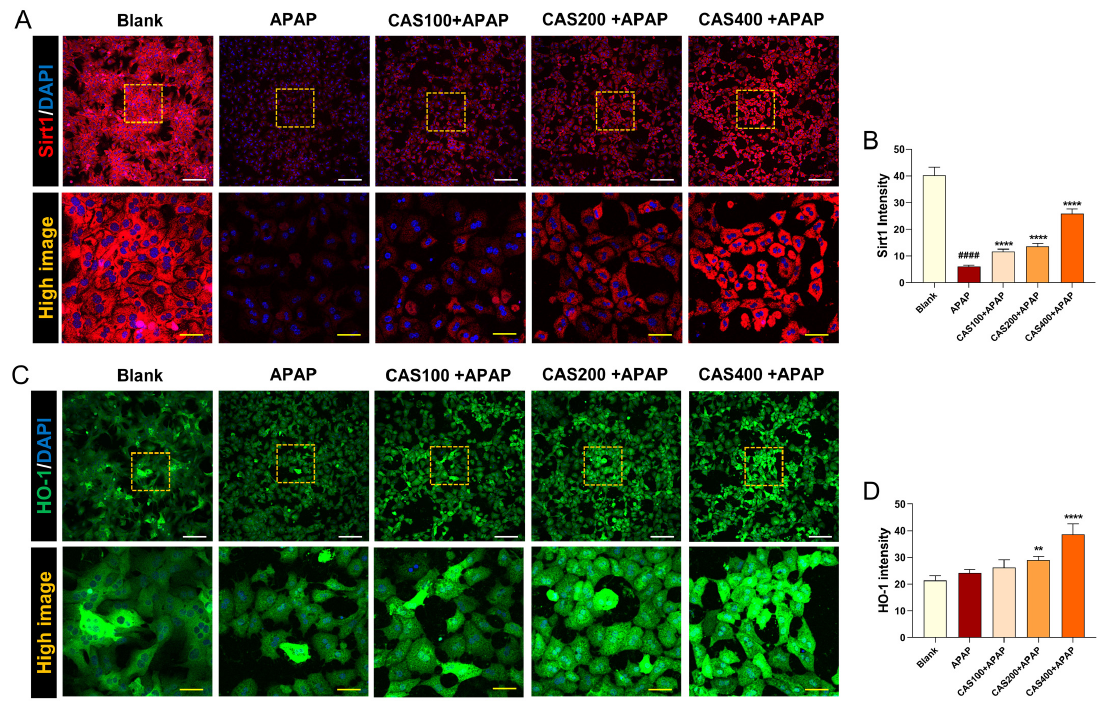
Figure 2. The hepatoprotective effects of CAS on APAP-induced hepatotoxicity involve the upregulation of Sirt1/HO-1 expression in primary mouse hepatocytes. ( A ) Representative confocal images of immunocytochemistry for Sirt1 (red) in the blank, APAP, and CAS groups. White scale bar = 200 μ m, yellow scale bar = 50 μ m. ( B ) Quantitative analysis of the relative fluorescence intensity of Sirt1 in each group ( n = 6). ( C ) Representative confocal images of immunocytochemistry for HO-1 (green) in the blank, control, and CAS groups. White scale bar = 200 μ m, yellow scale bar = 50 μ m. ( D ) Quantitative analysis of the relative fluorescence intensity of HO-1 in each group ( n = 6). The data are expressed as the mean ± SEM and were analyzed via ordinary ANOVA with Tukey’s post-hoc analysis. Significant differences are indicated as follows: #### p < 0.0001 vs. blank group; ** p < 0.01 and **** p < 0.0001 vs. APAP group.